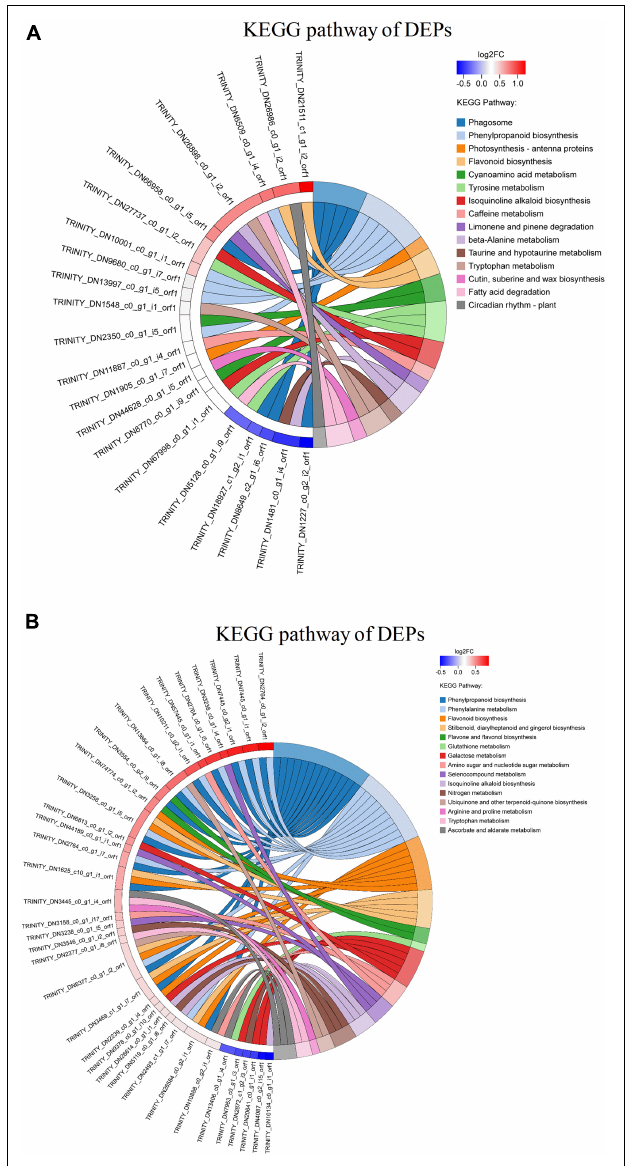
FIGURE 7 | KEGG enrichment of differentially expressed proteins in (A) GT11 and (B) B8 varieties of sugarcane inoculated with E. roggenkampii ED5 as compared to control. The KEGG-enriched string diagram depicted the relationship between the target protein set and the KEGG pathway annotation and enrichment. The left side indicated the proteins and the log2FC was displayed in order from top to bottom. The larger the log2FC, the greater the difference in the expression of the upregulated proteins. The smaller the log2FC, the greater the difference in the expression of the downregulated proteins. The closer the log2FC was to 0, the smaller the difference in the fold of differential expression of the proteins. The right gave the name of the KEGG pathway that enriched the target protein and the Z score. The count represented the number of proteins associated with this pathway. For the total number of target proteins, up represented the number of upregulated proteins linked in this pathway, and down represented the number of downregulated proteins involved in this pathway. Z score > 0 meant that there were more upregulated proteins than downregulated proteins involved in this pathway, and this pathway was more likely to be activated. Z score < 0 indicated that